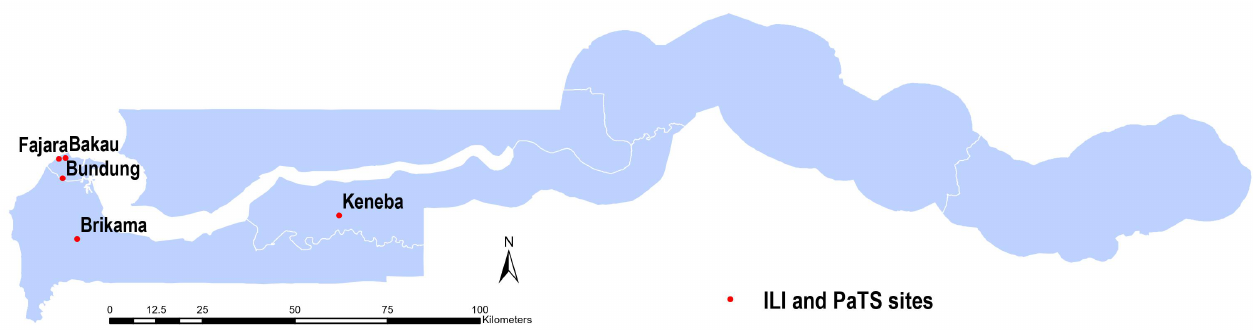
Figure 1. A map of The Gambia showing sites where participants were recruited for the two studies. The PaTS study sites were in Brikama, Bundung, Bakau and Fajara. The influenza-like illness (ILI) study sites were in Keneba and Fajara.